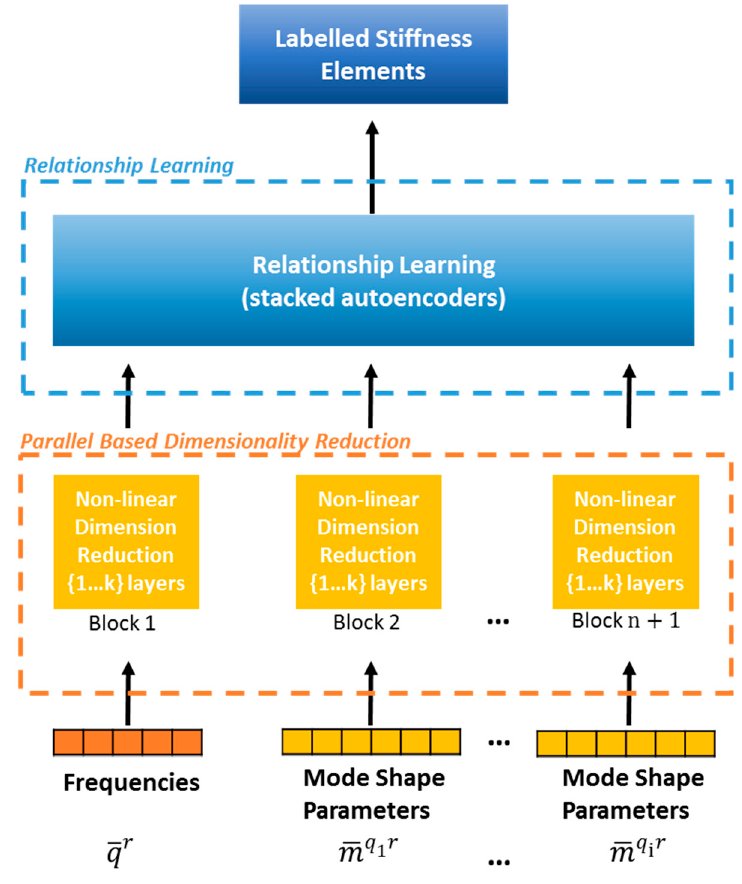
Figure 1. Proposed parallel based sparse auto-encoder framework.